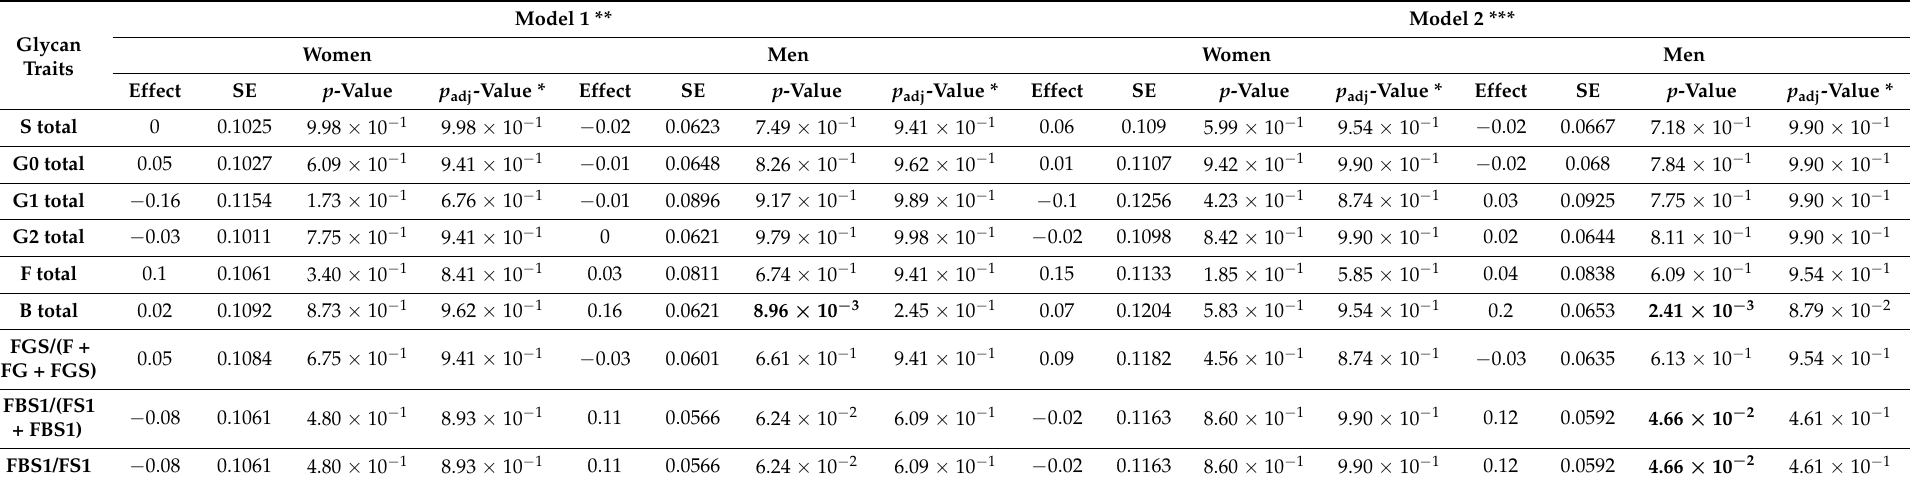
Table 3. Statistical analysis of IgG N-glycan derived traits in CAD+ versus CAD − cases during the two-year